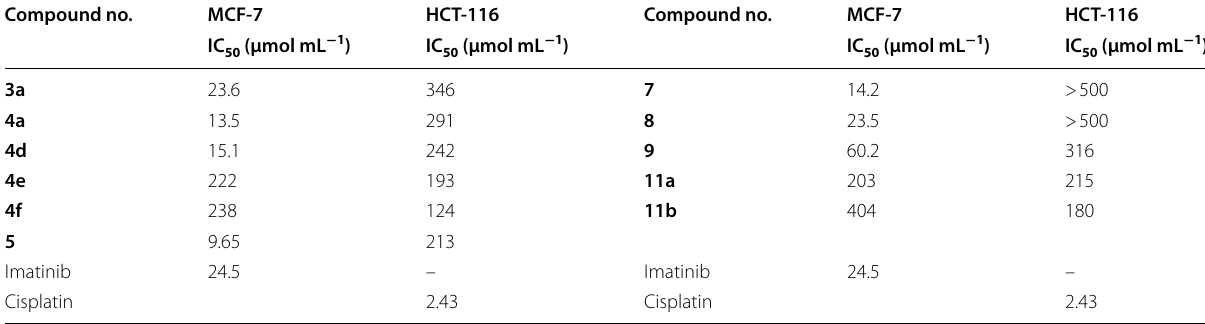
Table 1 Cytotoxicity (IC , μmol mL − 1 ) of the synthesized compounds (3a–11b) against MCF-7 and HCT-116 human 50 cancer cell lines Compound